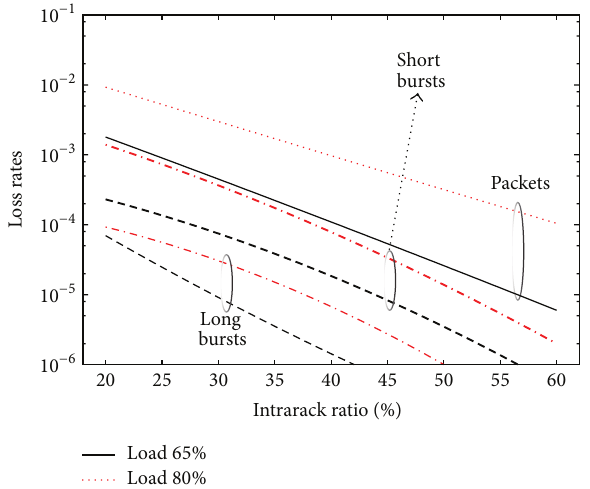
Figure 5: Average data loss rates in the HOS network as a function of the IR at 65% and 80% of offered